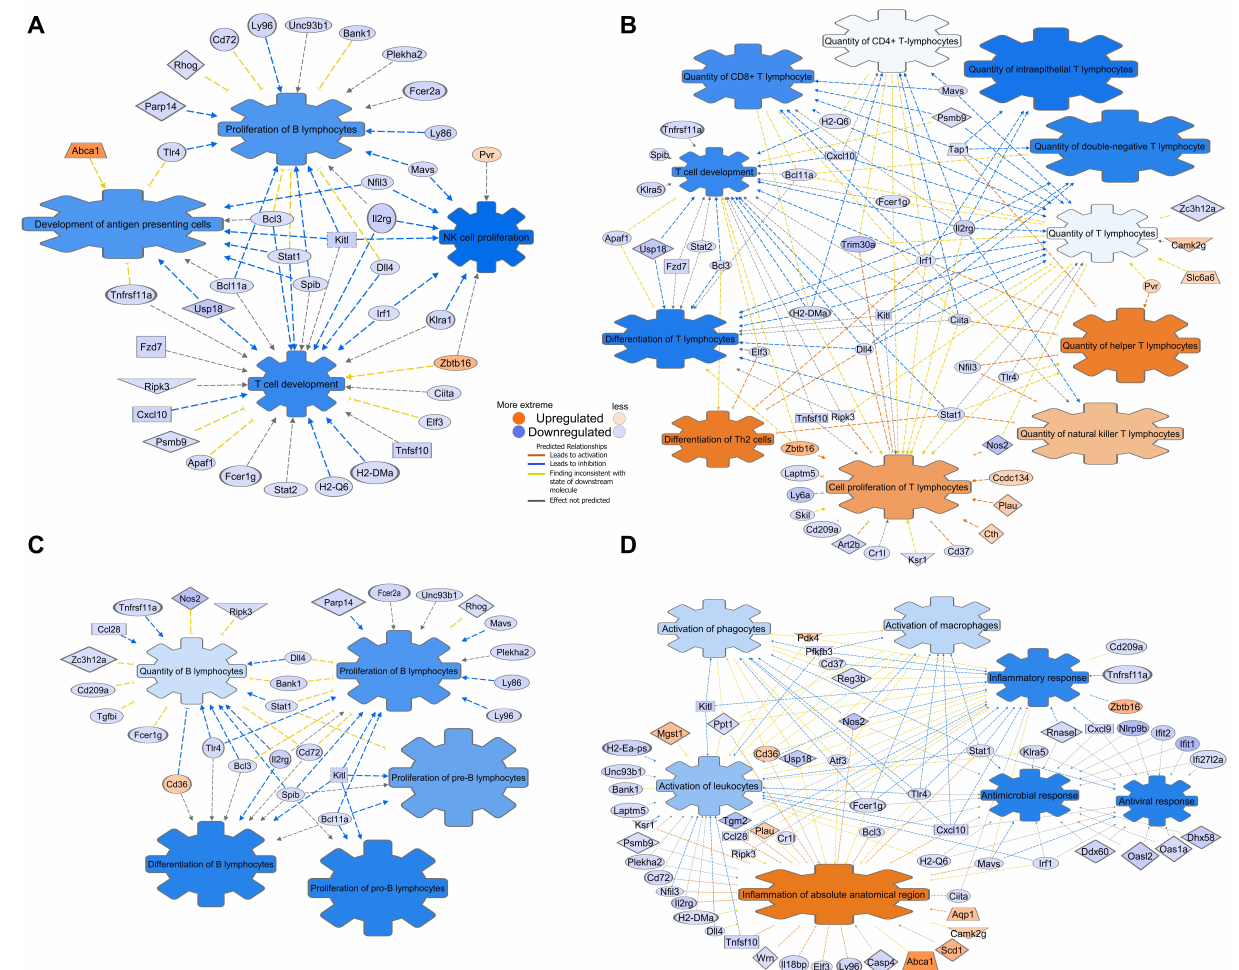
Figure 4. CR reduces T-, B-, NK- and antigen-presenting cells expression, their functional activity, and suppresses intercon- nections between major immune cell type populations. ( A ) IPA network analysis reveals global suppression of the major immune cell types. ( B ) T and NK lymphocytes network. ( C ) B lymphocyte network. ( D ) Inflammatory cells network. The Path Designer in IPA colors the disease/functional annotations and edges based on their current predicted effects; orange is predicted activation, blue is predicted inhibition, yellow is findings inconsistent with the state of the downstream molecule, and grey color is effect not